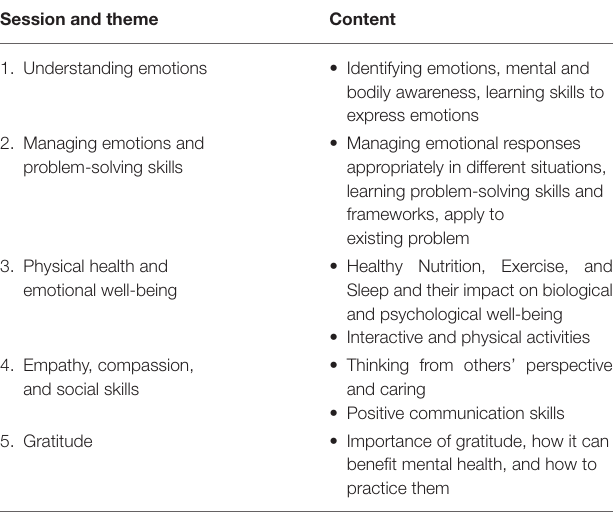
TABLE 2 | Example of program outline of a primary school bio-psycho-social mental health promotion. Session and theme